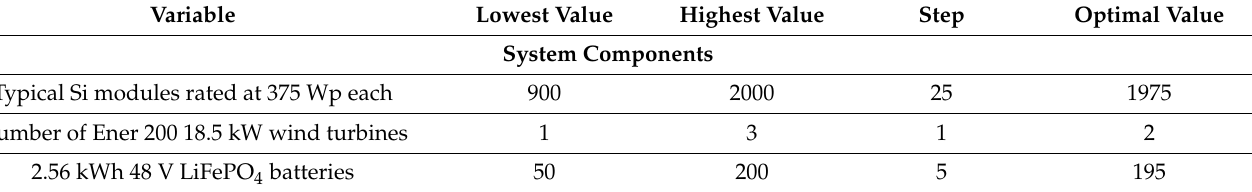
Table A13. Case study 20.